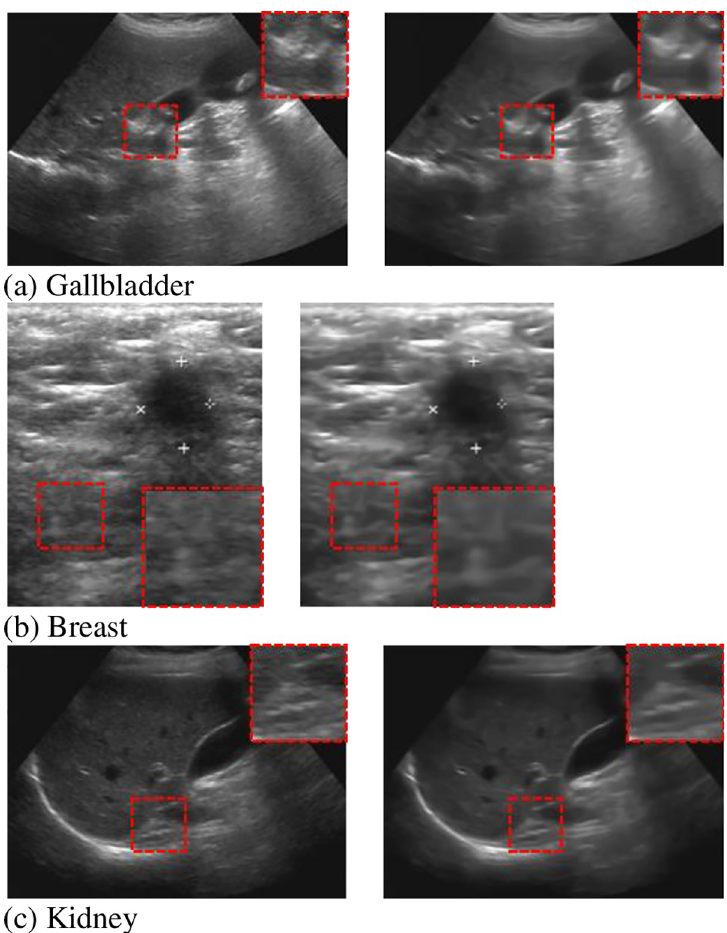
Fig 10. The proposed method to denoise the three organs (left is the original image, and the right is the denoising image).